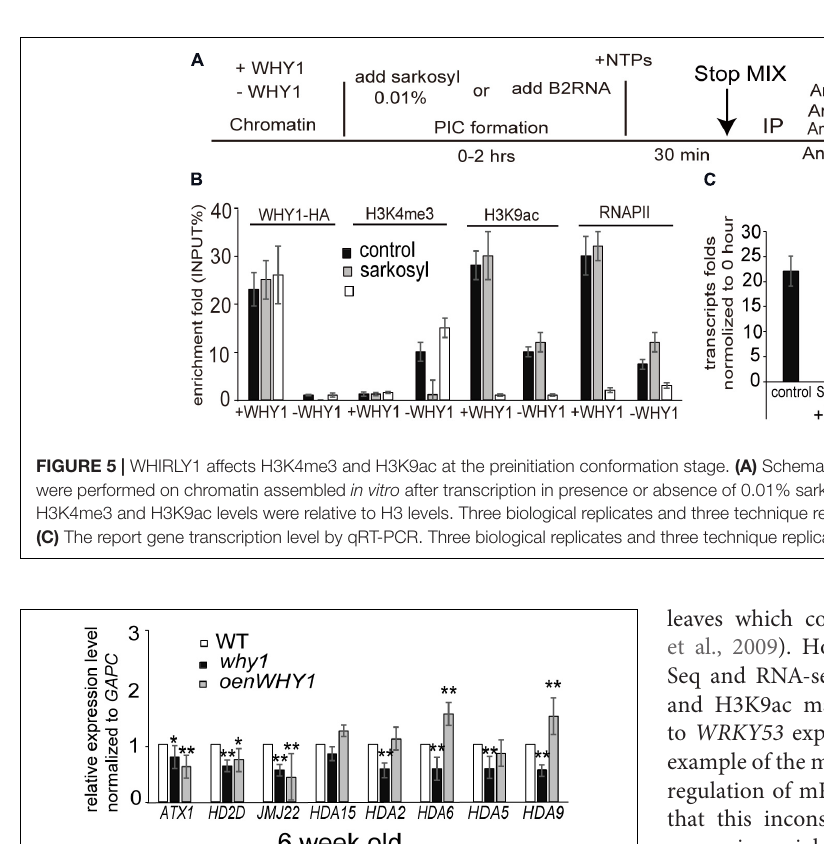
stage, and high ratio of H3K9ac/H3K4me2-3 determines the transcription level of WRKY53 and leaf senescence